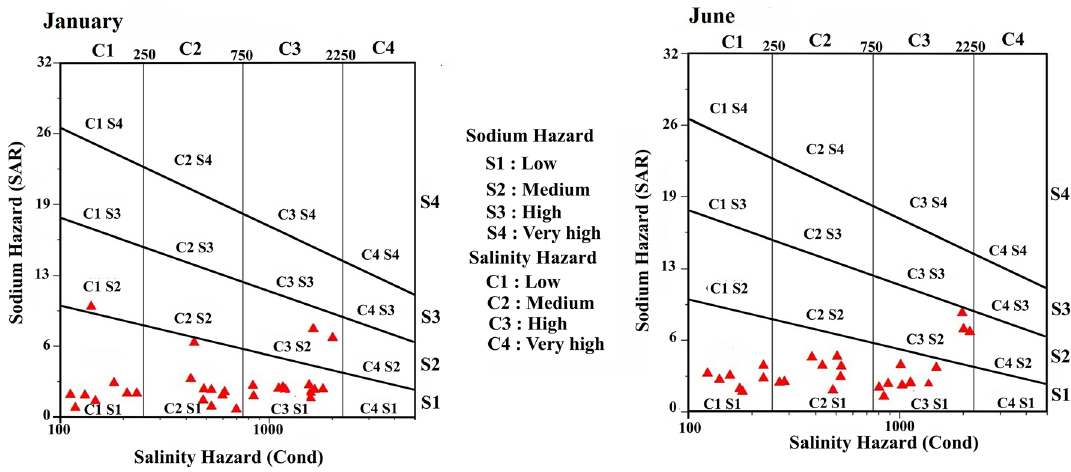
Fig. 7 USSL classification of groundwater samples